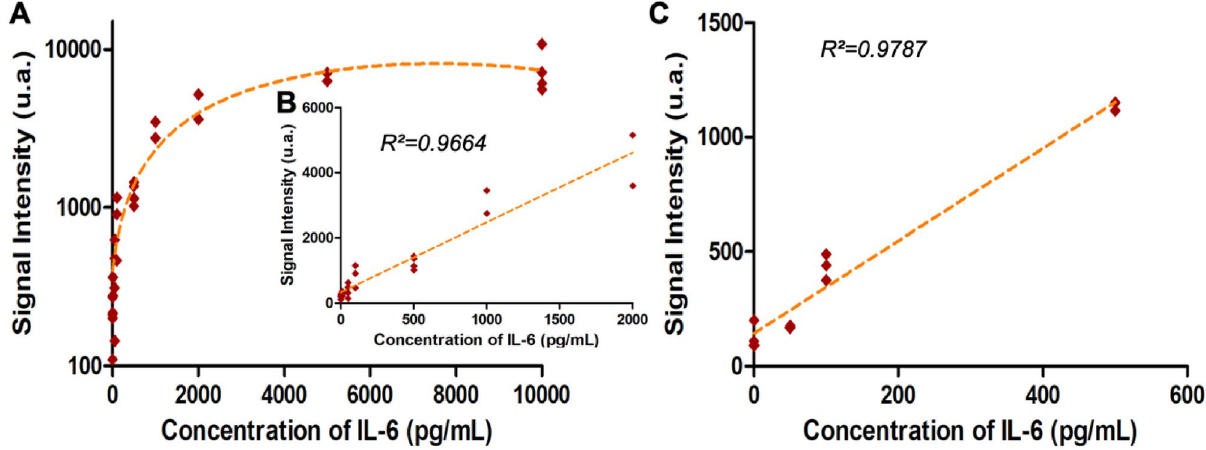
Figure 4. Evaluation of the performance of the system. ( A ) and ( B ) IL-6 Immunoassay calibration curve, on chip signal intensity as function of the IL-6 concentration in Tris–HCl buffer where the limit of detection is 6 pg/mL and C) linear dynamic range of the calibration curve with IL-6 spiked in Fetal Bovine Serum (FBS) (annotation of the coefficient of regression for each linear regression). The analysis was performed as described in the Material and